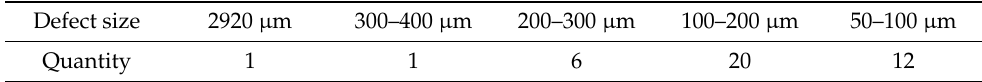
Table 3. Statistics of defect dimensions in 18CrNiMo7-6